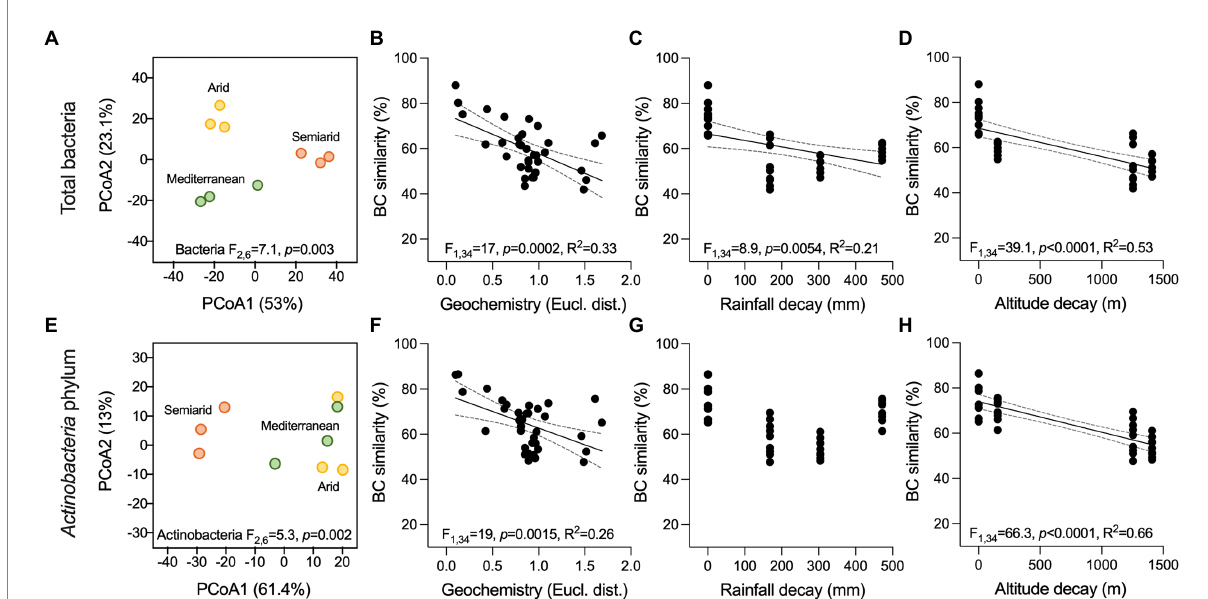
FIGURE 2 Beta-diversity of bacterial communities associated with the ruin stones along the climatic transect. (A,E) Principal coordinate analysis (PCoA) of the total bacterial communities and members of the Actinobacteria phylum associated with the stones, respectively. Results of PERMANOVA are reported in the graphs. (B–D, F–H) Bray Curtis (BC) similarity distance decay in function of (C,F) stone geochemical conditions (Euclidean distance), (D,G) average precipitations (mm/years), and (E,H) altitude (m) in the total bacterial communities and members of the Actinobacteria phylum, respectively. Black lines indicate significant linear regressions, and gray-dashed lines the 95% confidence bands; value of p s and R 2 are reported in the graphs. Non-significant regression lines ( p > 0.05) are not